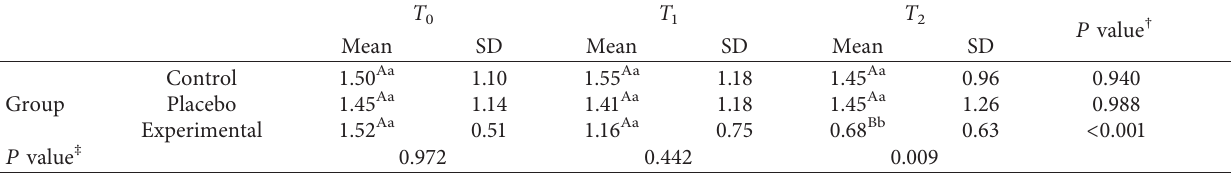
Table 2: Comparison of the mean hyperplastic index (HI) from T 0 to T 2 in control, placebo, and experimental groups (mean ± SD). T 0 Group